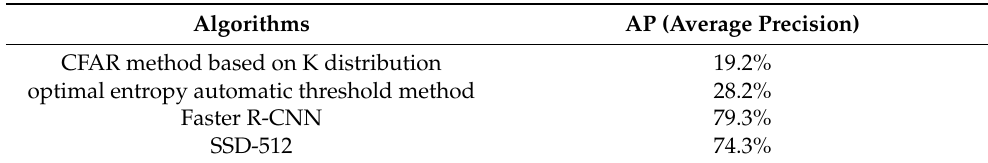
Table 1. The performance difference between traditional-based detectors and deep learning-based detectors on the same condition